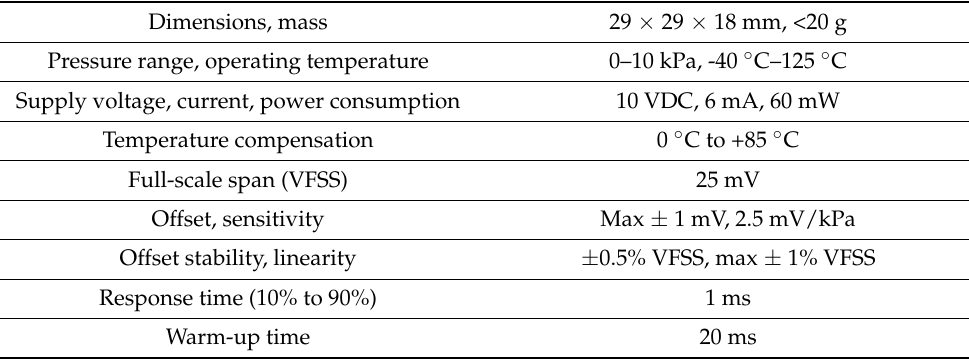
Table 2. The main operating characteristics of the